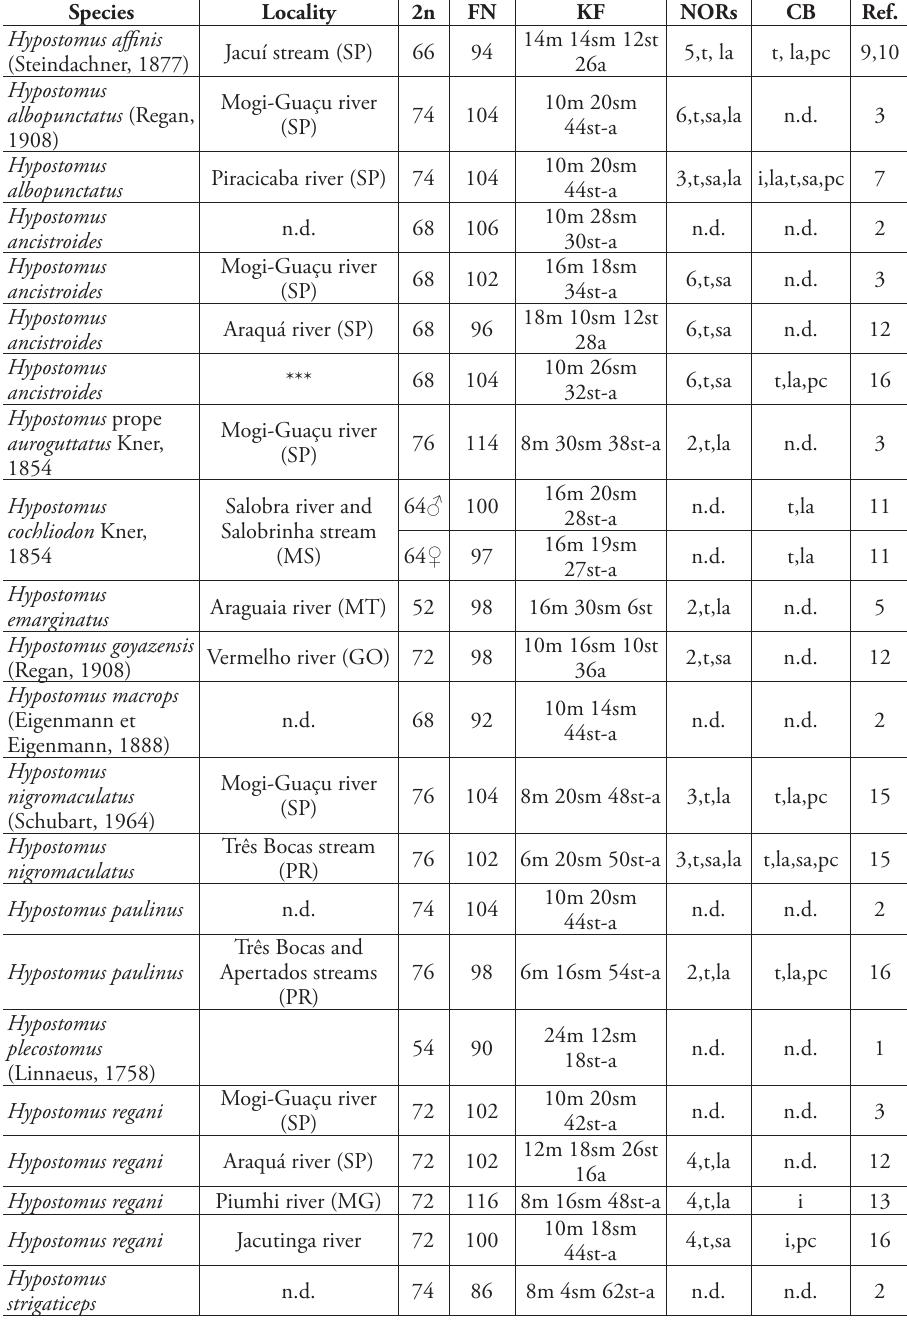
table 1. A summary of cytogenetic data available for the genus Hypostomus .